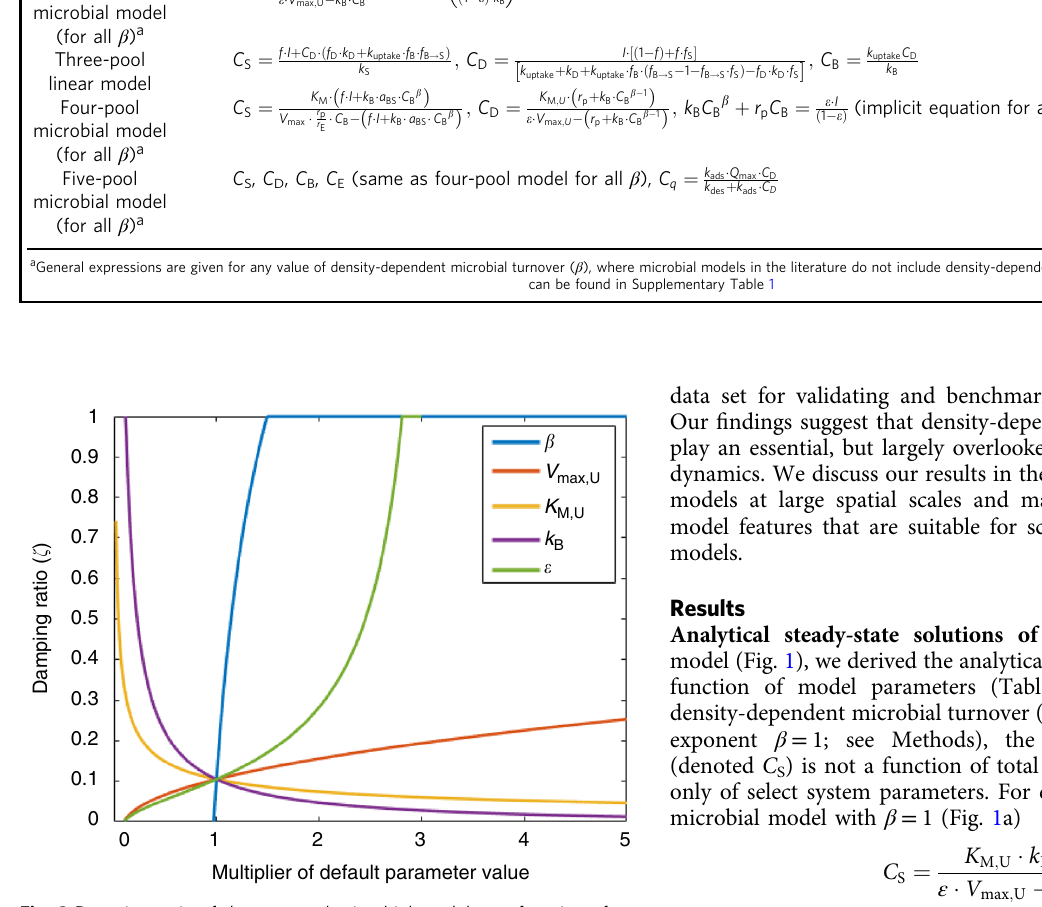
Fig. 2 Damping ratio of the two-pool microbial model as a function of the model parameters. The damping ratio ( ζ ) is a metric that depicts the degree of oscillatory behavior of the linearized system near its steady state, where ζ = 1 signi fi es a stable node, 0 < ζ < 1 damped (diminishing) oscillations, − 1 < ζ < 0 unstable (growing) oscillations, and ζ = − 1 an unstable node. Here all parameters were varied independently from their default value (Supplementary Table 1) by the given multiplier ( x -axis) to illustrate the inherent sensitivity of the oscillations on the parameter values. The model stability is very sensitive to the